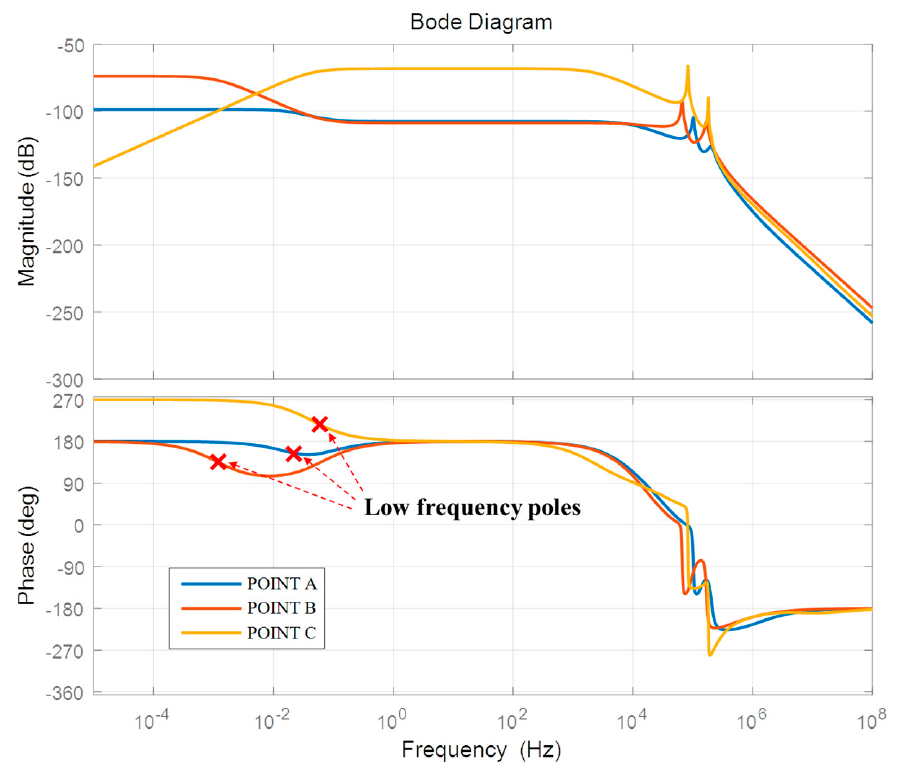
Figure 10. Magnitude and phase plot of the control-to-output transfer function.